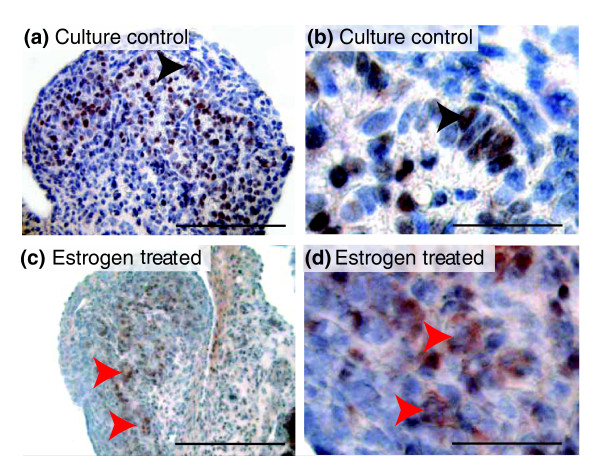
The distribution of SOX9 protein in oestrogen-treated and control cultures. Immunohistochemistry showing the subcellular distribution of SOX9 in control and oestrogen cultured XY gonads, using AEC+ chromogen red/brown staining (Dako) and counterstained with haematoxylin (blue). In the culture controls (a; magnified in b) localization was nuclear (black arrowhead) and confined to the Sertoli cells of the developing seminiferous cords. In contrast, in the oestrogen-cultured gonads (c; magnified in d), SOX9 was largely cytoplasmic (red arrowheads) and no or very few nuclei were stained. Scale bars are 100 μm in (a) and (b) and 25 μm in (c) and (d).